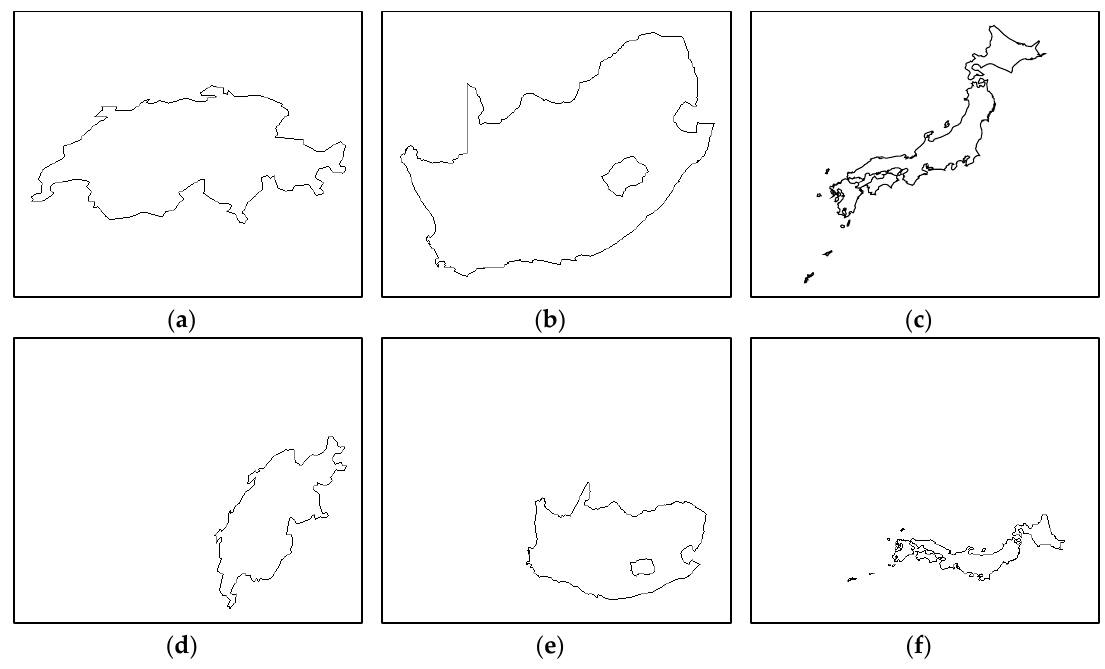
Figure 10. Three countries represented by different types of polygons: ( a ) Switzerland, ( b ) South Africa, ( c ) Japan, ( d ) Switzerland after transformation, ( e ) South Africa after transformation; and ( f ) Japan after transformation. Table 1. Hu moment invariants of six polygons.